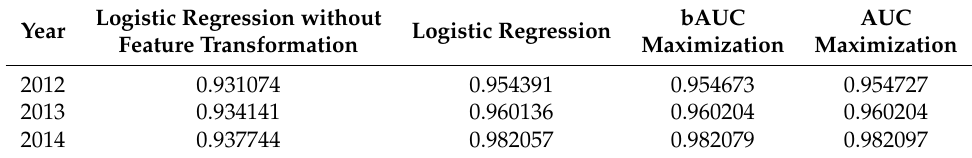
Table 4. Results for models with three features, DTI, Employment Length, and Risk